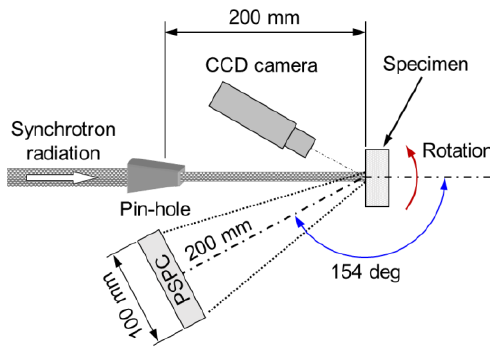
Figure 2. The XRD with synchrotron radiation setup at the Photon Factory (PF).